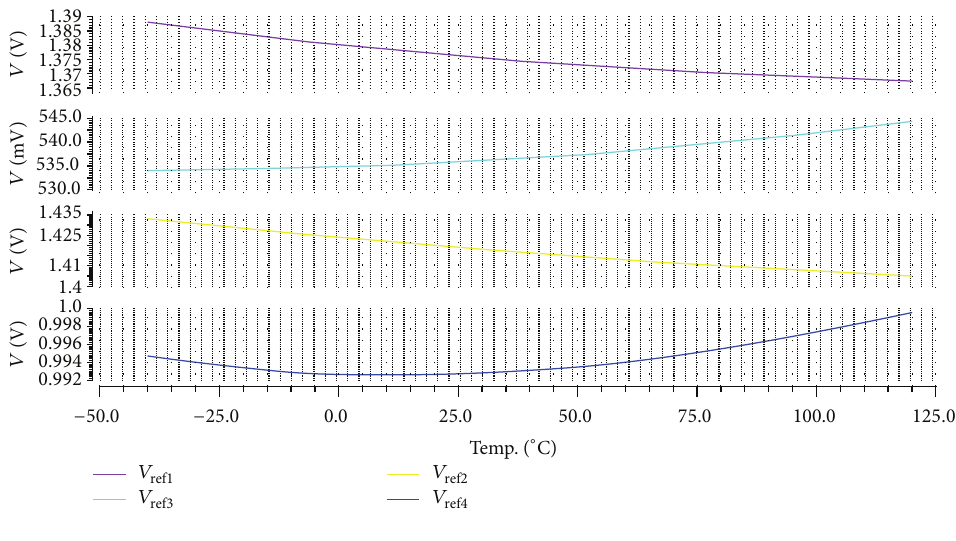
Figure 7: Reference voltages versus temperature.